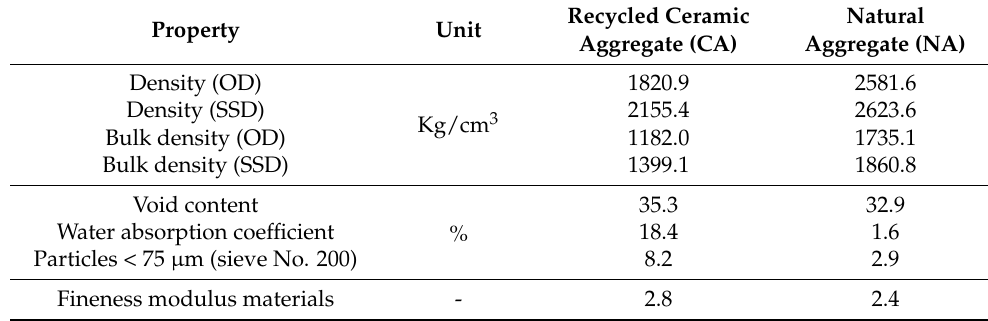
Table 1. Physical properties of aggregates